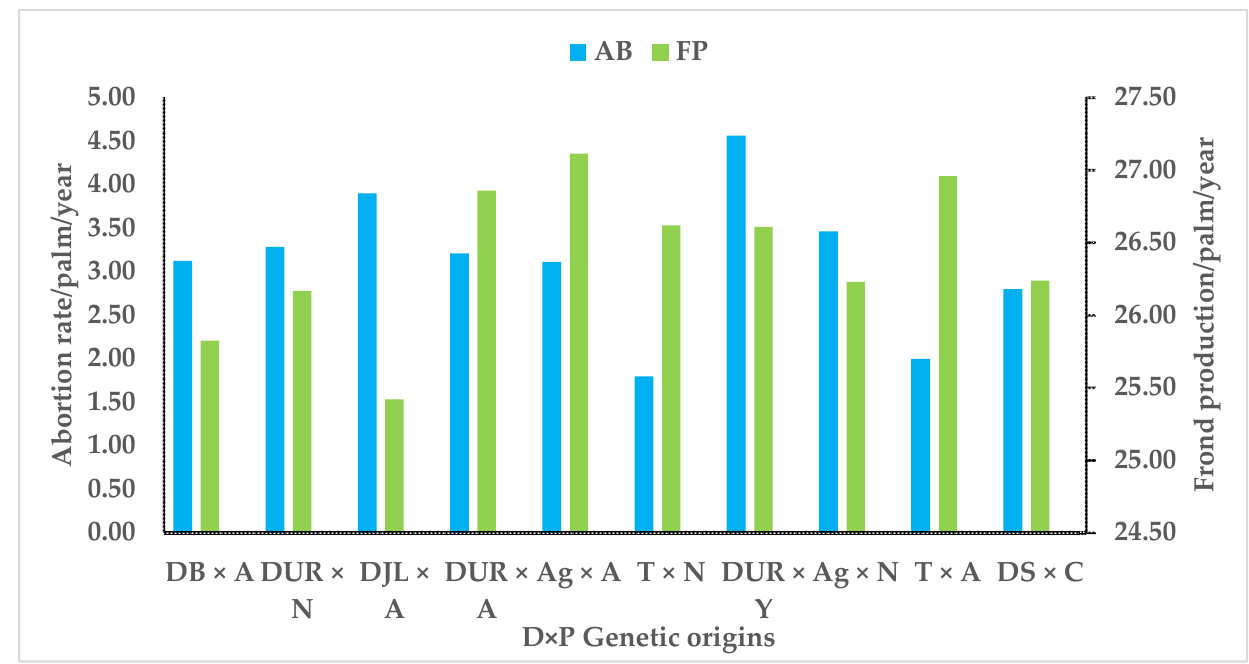
Figure 3. Mean performance of frond production and abortion rate among genetic origins per palm per year. AB, abortion (palm − 1 yr − 1 ); FP, frond production; Ag, Angola; A, AVROS (Algemene Vereniging rubber planters); N, Nigeria; C, Cameroon; DJL, Deli Johor Labis; DUR, Deli Ulu Remis; T, Tanzania; Y, Yangambi; DB, deli Banting.